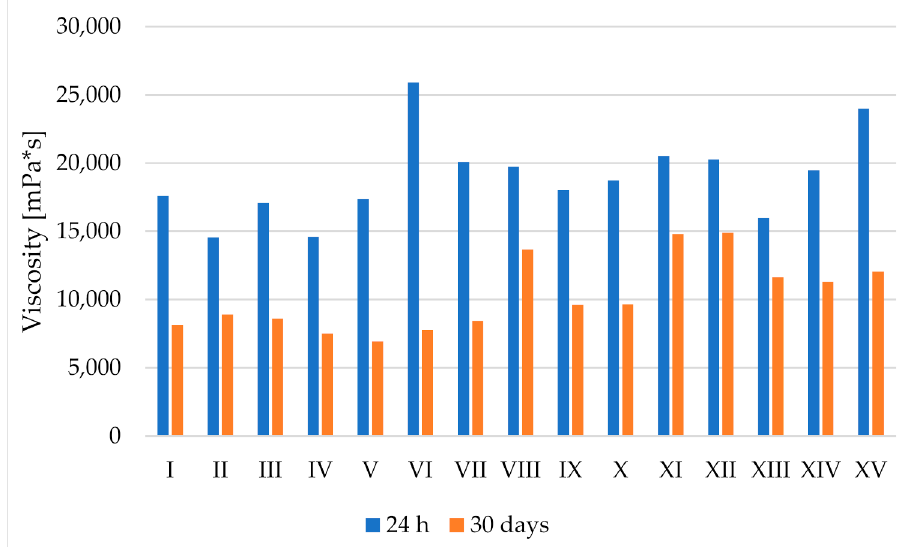
Figure 1. Viscosity of emulsion systems after 24 h and 30 days. Legendary (I–XV) the same as in Table